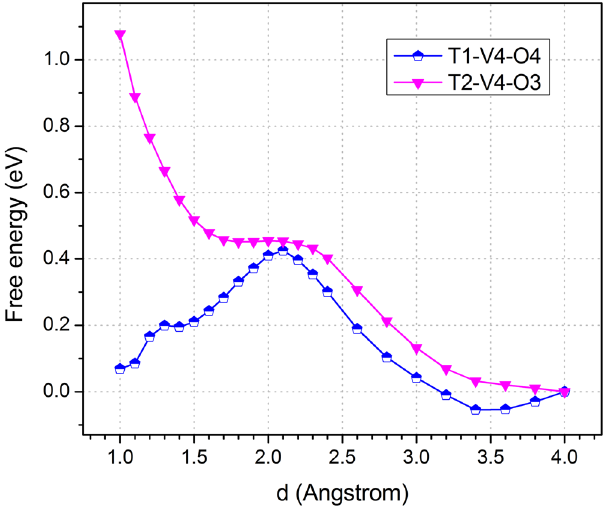
Figure 3. T1-V4-O4 and T2-V4-O3 are proton transport free energy profiles for attachment/detachment barriers of the corresponding structures. Here the “d” along horizontal axis is the distance between the proton and the target site to be attached. Other barriers are summarized in Table 1.